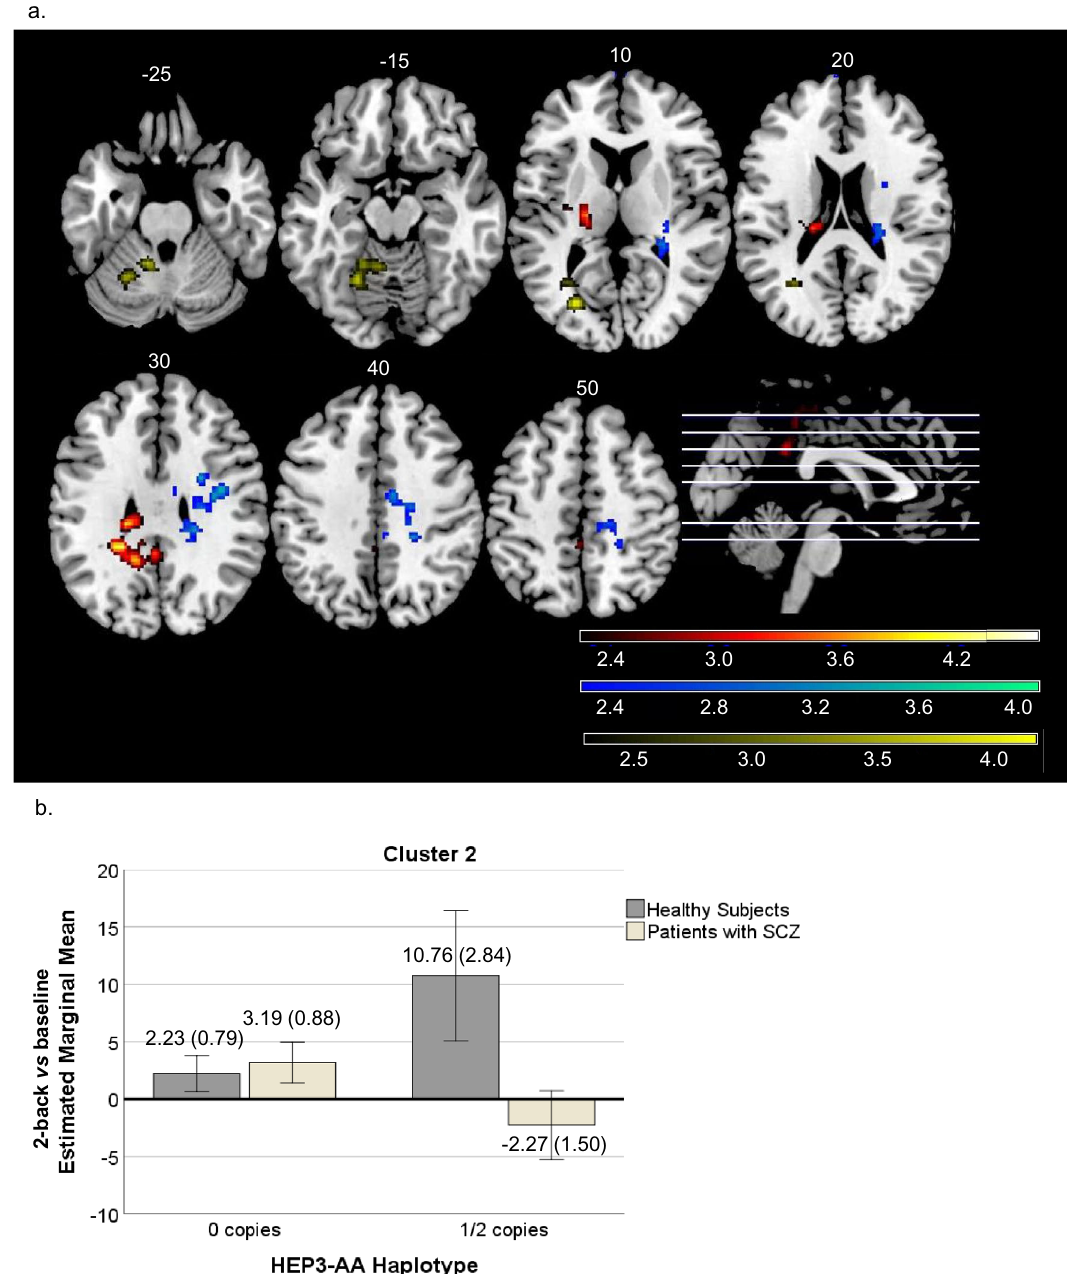
Figure 2. ( a ) Brain regions showing the axial view of the clusters with significant diagnosis × HEP3-AA interaction in 2-back vs baseline contrast. Cluster one is shown in red, cluster two in blue and cluster three in yellow. The right side of the image represents the right side of the brain. The MNI coordinates are given for each slice. Units of the bar are the corresponding β values from the regression standardised to Z-scores. ( b ) Plot corresponding to the 2nd cluster’s estimated marginal mean activity scores ± 2 standard error (SE) for the HEP3-AA haplotype in healthy subjects (92.9% with 0 copies and 7.10% with 1 or 2 (1/2) copies) and patients with SZ (74.30% with 0 copies and 25.70% with 1 or 2 (1/2)